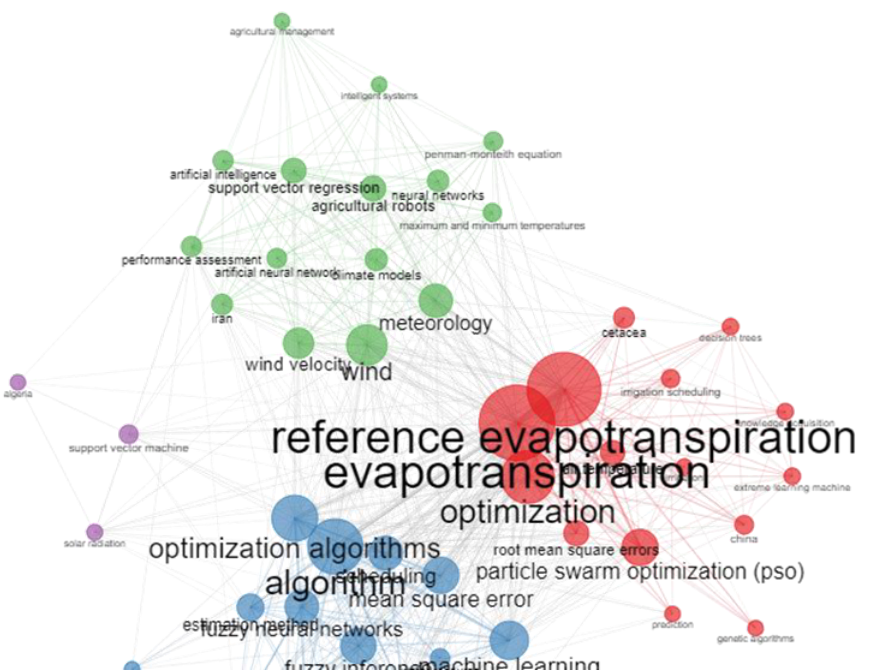
Figure 6. A co-occurrence networks structure.